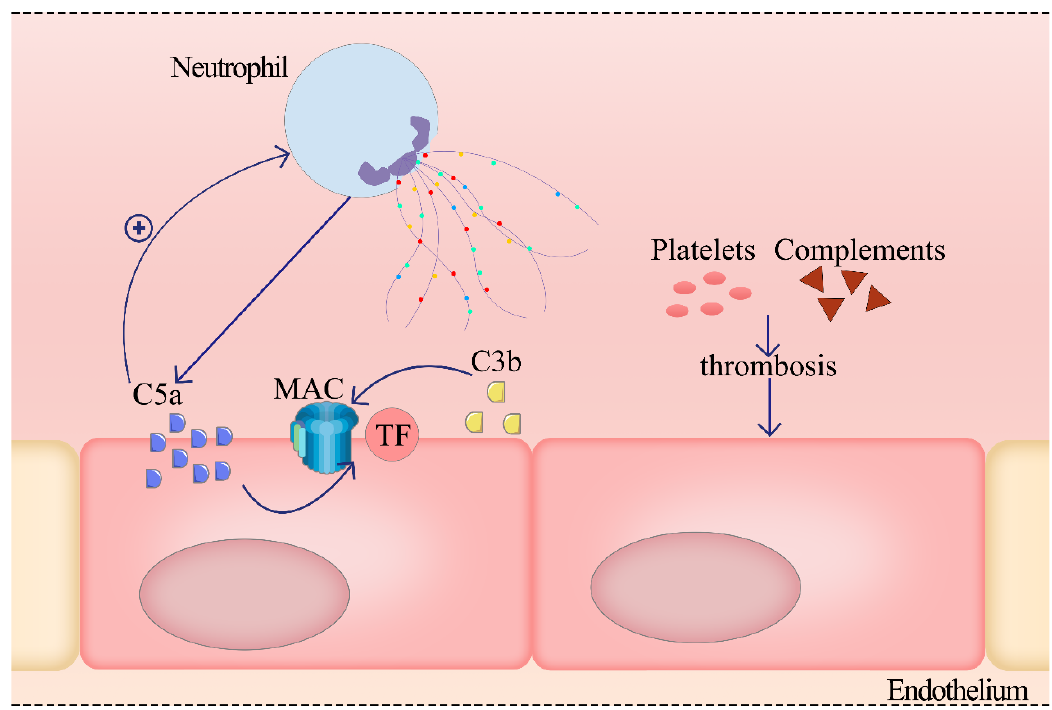
Figure 4. NETs-derived C3b activates the complement cascade, which amplifies the inflammatory response by activating neutrophils. The interaction of membrane attack complex (MAC) with C5a enhances TF expression in ECs and destroys ECs. Some factors in the complement system interact with platelets to enhance procoagulability. More neutrophils will be recruited by complement stim- ulation, and complement can also be deposited on NETs to continue to